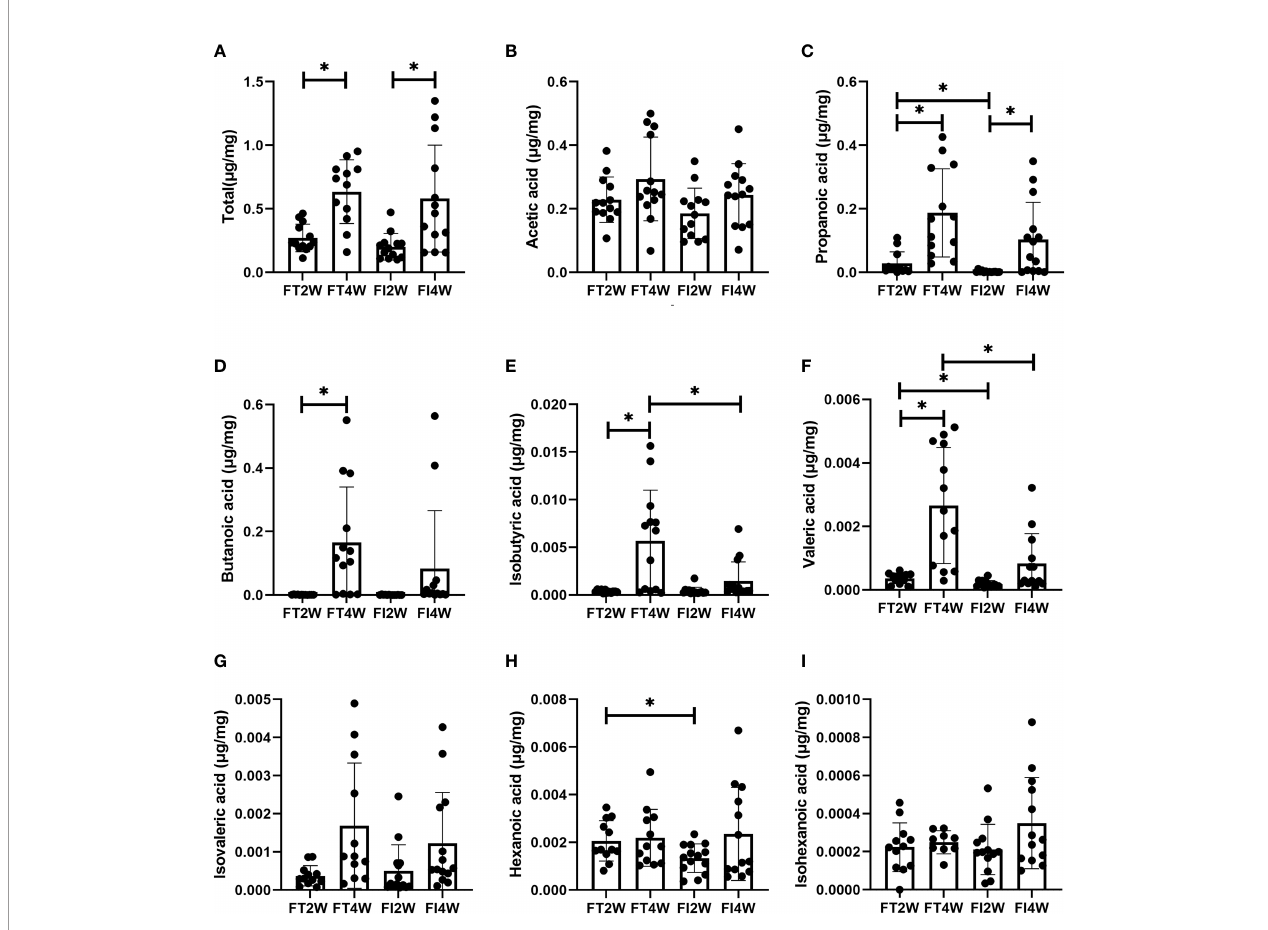
FIGURE 5 | Comparison of concentrations of SCFAs between the FT and FI groups and between 2 and 4 weeks of life. (A) Total SCFAs, (B) acetic acid, (C) propionic acid, (D) butanoic acid, (E) isobutyric acid, (F) valeric acid, (G) isovaleric acid, (H) hexanoic acid, (I) isohexanoic acid. * P <